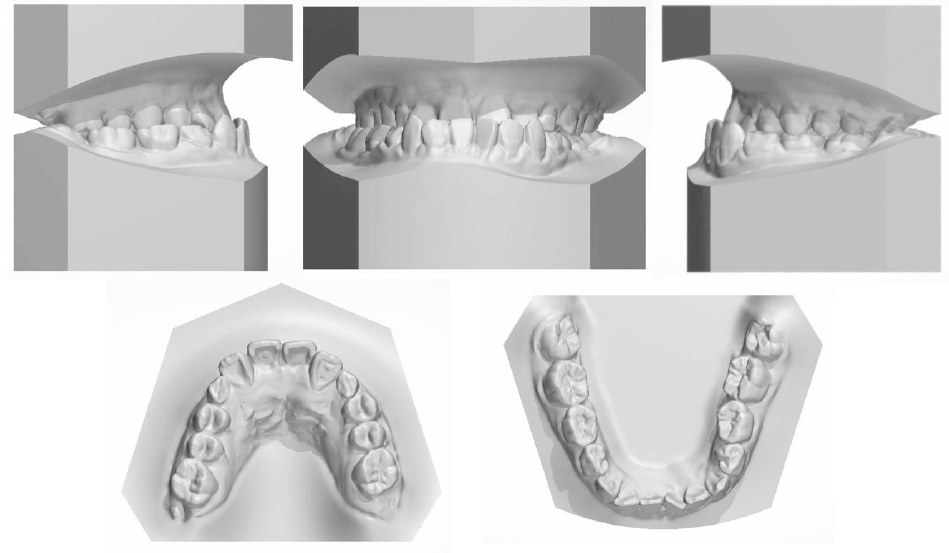
Figure 2. The pretreatment dental cast.